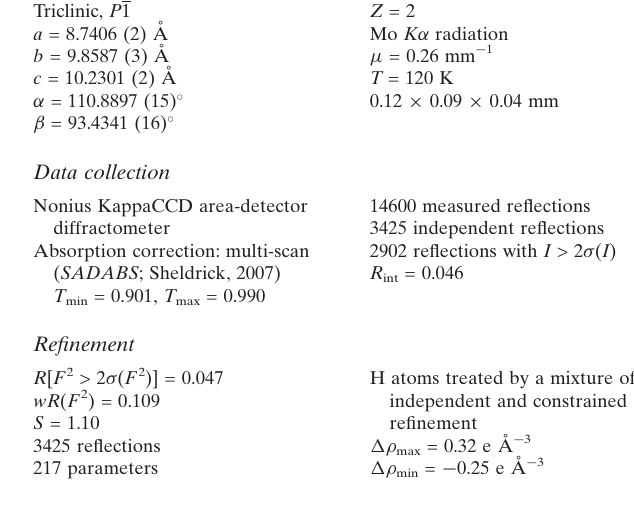
Data collection Nonius KappaCCD area-detector diffractometer